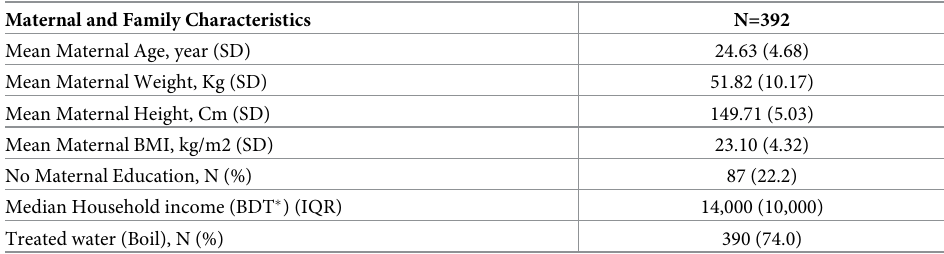
Table 4. Maternal and family demographics. Maternal and Family Characteristics